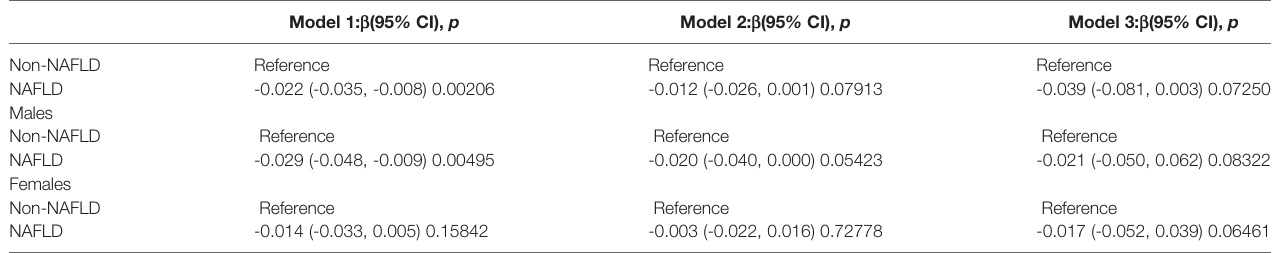
TABLE 2 | Association between NAFLD and lumbar bone mineral density (g/cm2) strati fi ed by gender.